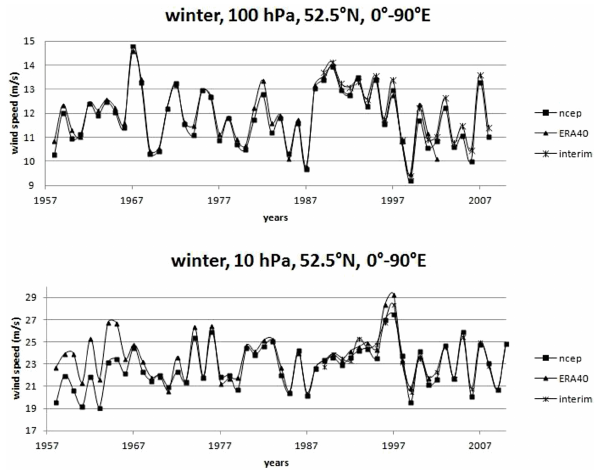
Fig. 2. Winter (October–March) averages for 52.5 ◦ N, sector 0– 90 ◦ E, 100hPa (top) and 10hPa (bottom). Where data of more than one reanalysis overlap, only one line is displayed.